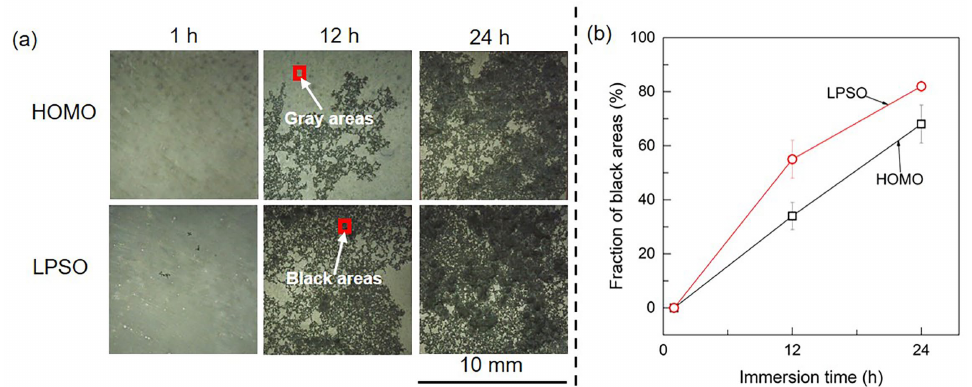
Figure 3. Optical images of the HOMO and LPSO samples: ( a ) optical images and ( b ) the fraction of black areas as a function of immersion time.